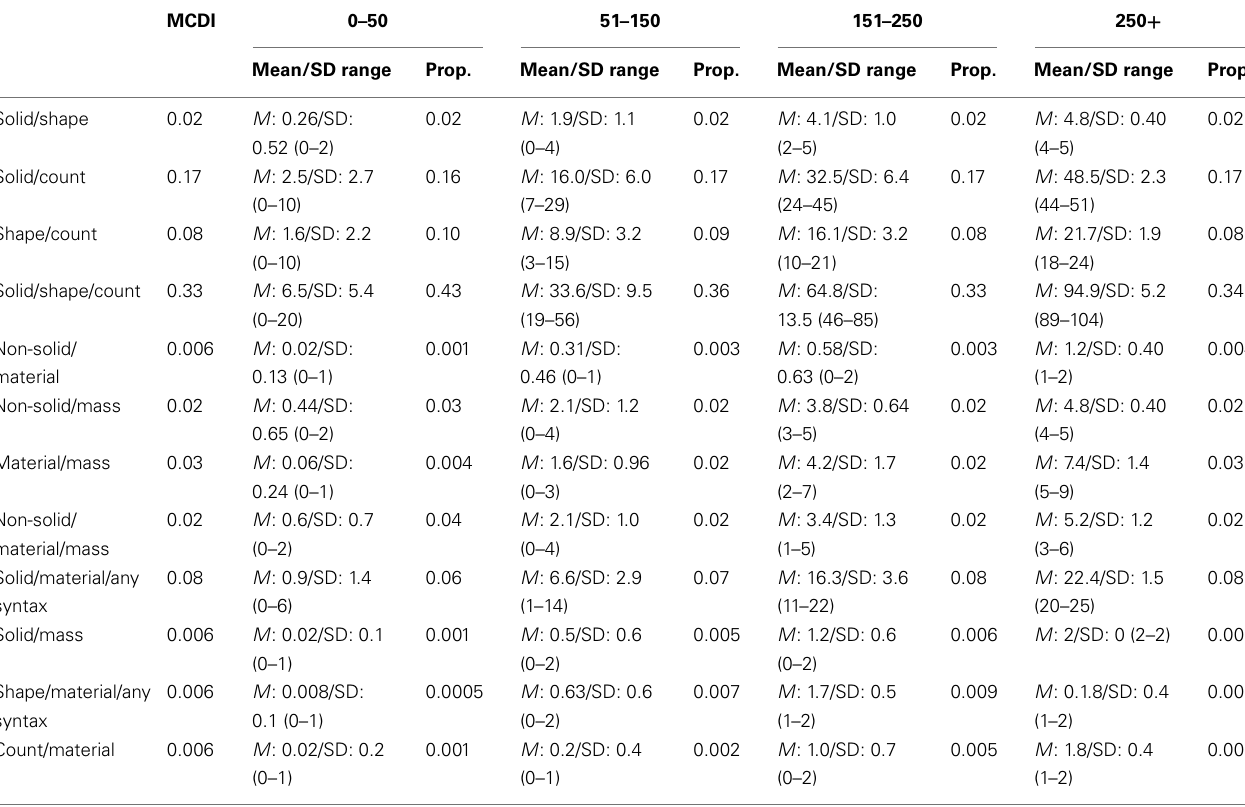
Table 2 | Mean, range, and proportion of nouns in each joint vocabulary classification for each vocabulary subgroup.